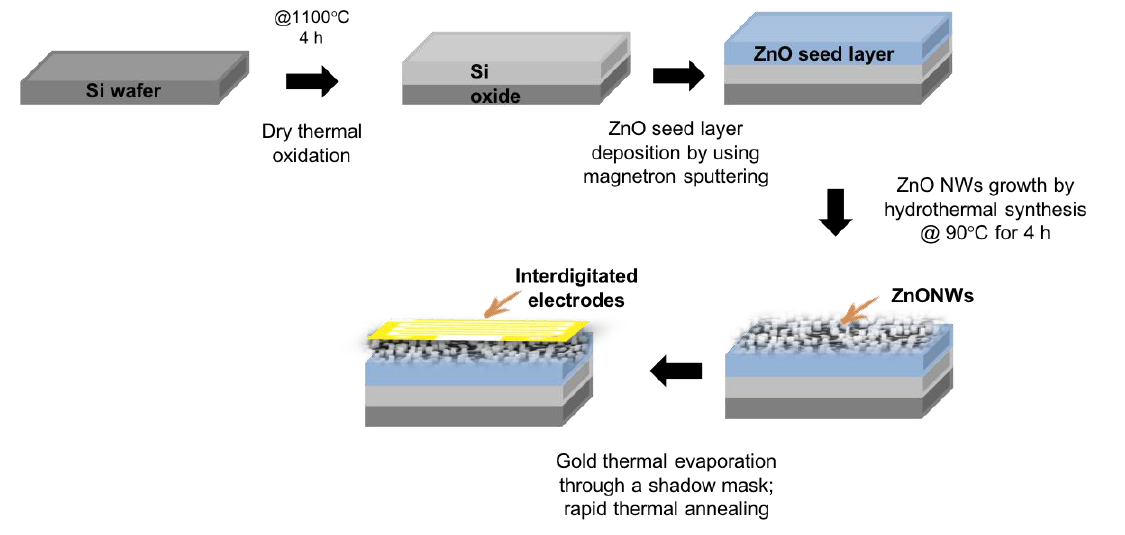
Figure 1. Fabrication process of the ZnONWs electrical sensor.